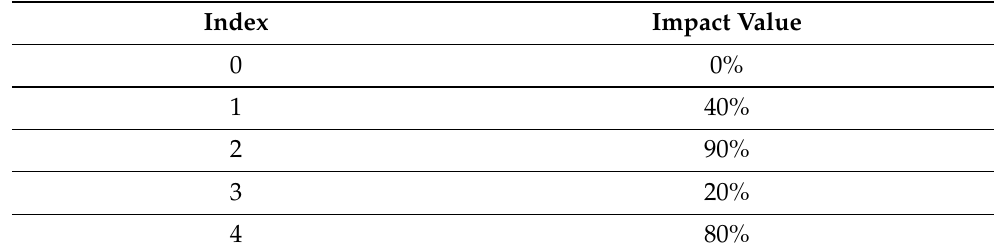
Table 3. Security profile (impact of